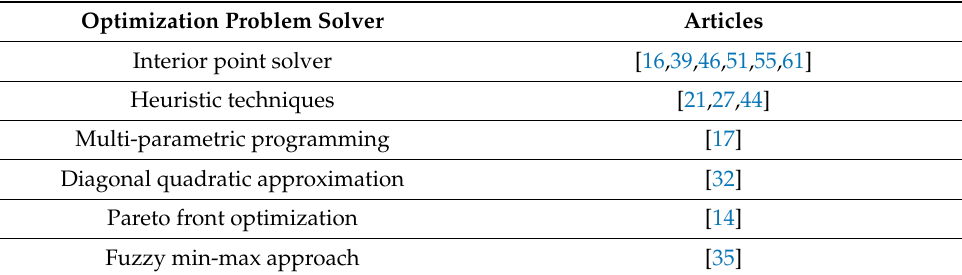
Table 4. Optimization-solving